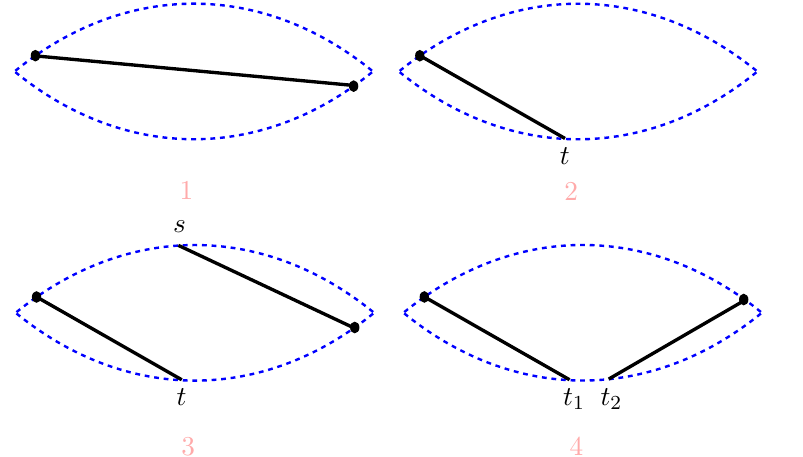
Figure 17 . Four diagrams contributing to the mixing matrix of the cusps with insertions of a scalar